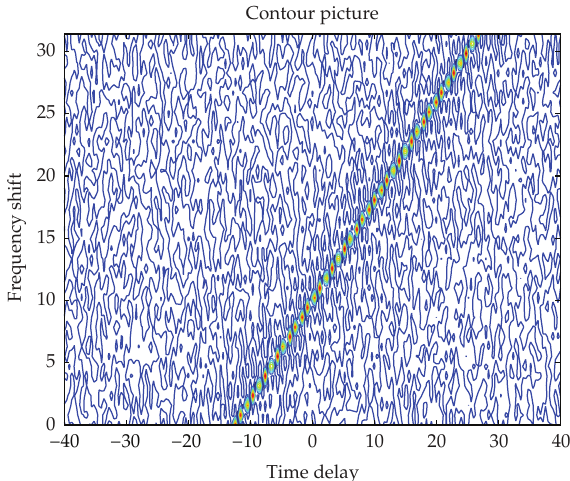
Figure 7: The contour picture of WVD of f (cid:4) t (cid:5) SNR (cid:7) − 5dB.